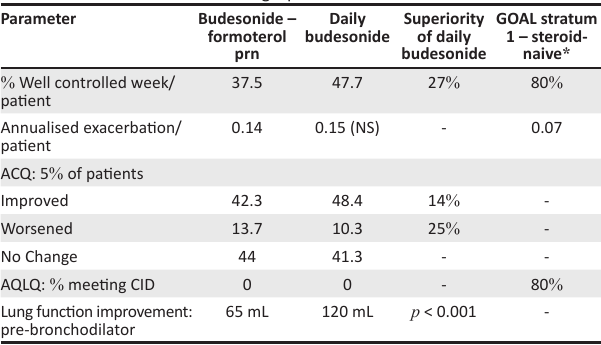
TABLE 1: A comparison of asthma control in the Symbicort Given as Needed in Mild Asthma studies versus Gaining Optimal Asthma